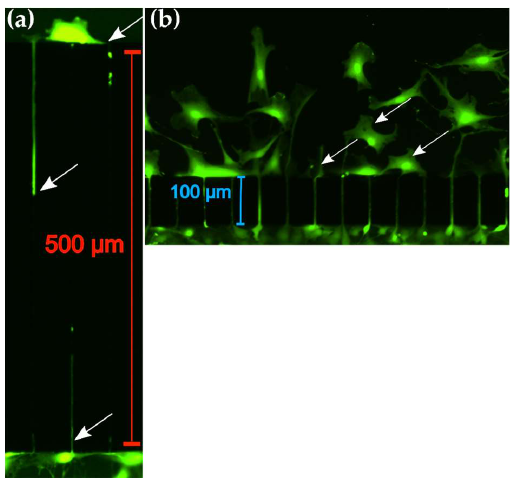
Figure 6. Effect of microchannel length on primary myoblast migration behavior. ( a ) Representative fluorescent image of cells crossing 500 µm length (width = 5 µm) microchannel from the proximal (bottom) to distal chamber (top). Arrows indicate cytoplasmic structures of cells in the microchannels. ( b ) Representative fluorescent image of cells crossing 100 µm length microchannel (width = 5 µm) from proximal (bottom) to distal (top) chamber. Arrows indicate cytoplasm structures after release of confinement from the microchannels.